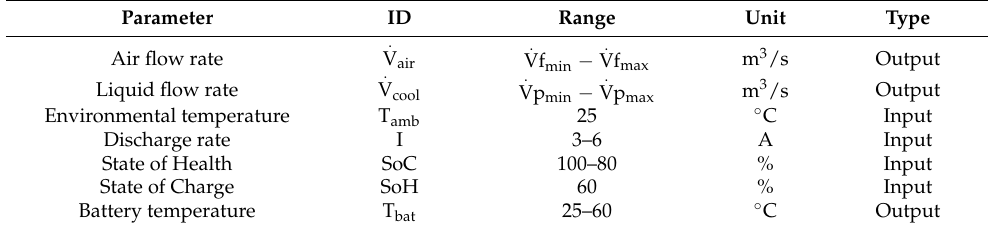
Table 3. Algorithm parameters and their constraints.